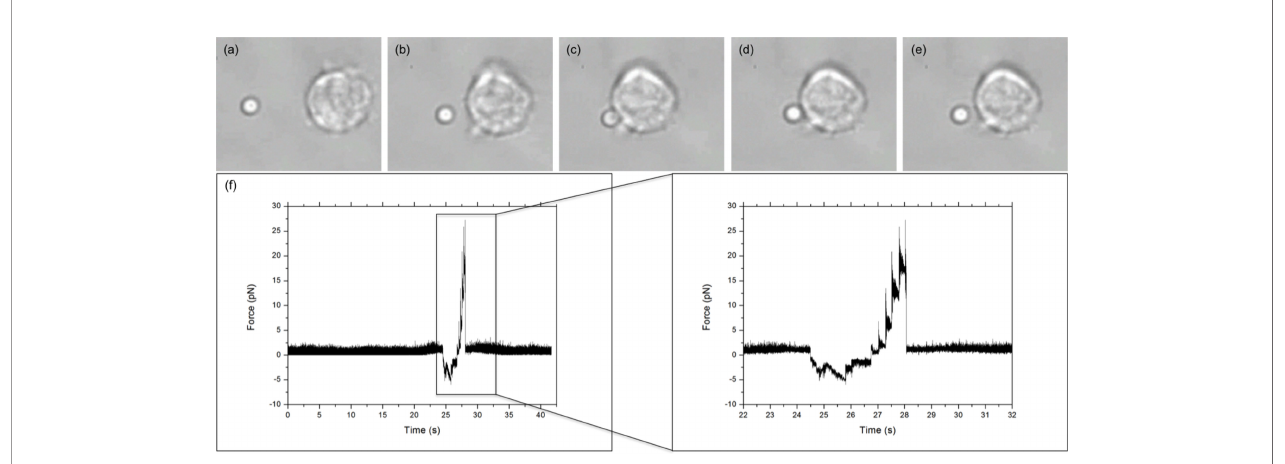
FIGURE 2 | LFA-1 – ICAM-1 adhesion measurement. (A – E) show the fi ve steps of an adhesion measurement: (A) trap stiffness; (B) approach; (C) stick; (D) pull; and (E) bond break. Arrow donates direction of stage/cell movement. (F) Typical force versus time graph obtained for an integrin – ligand unbinding event. The large peak, enlarged in the inset, represents the maximum unbinding force required to disrupt an integrin – ligand bond. The jagged pro fi le of the peak is due to the piezo stage moving in “ steps. ” .